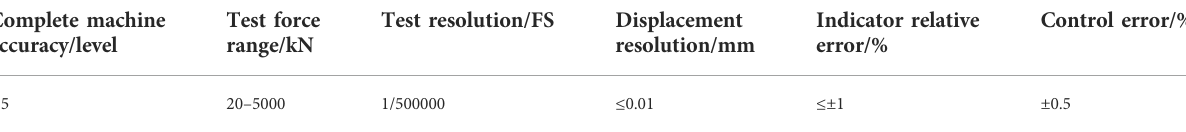
TABLE 15 Main properties of strength testing